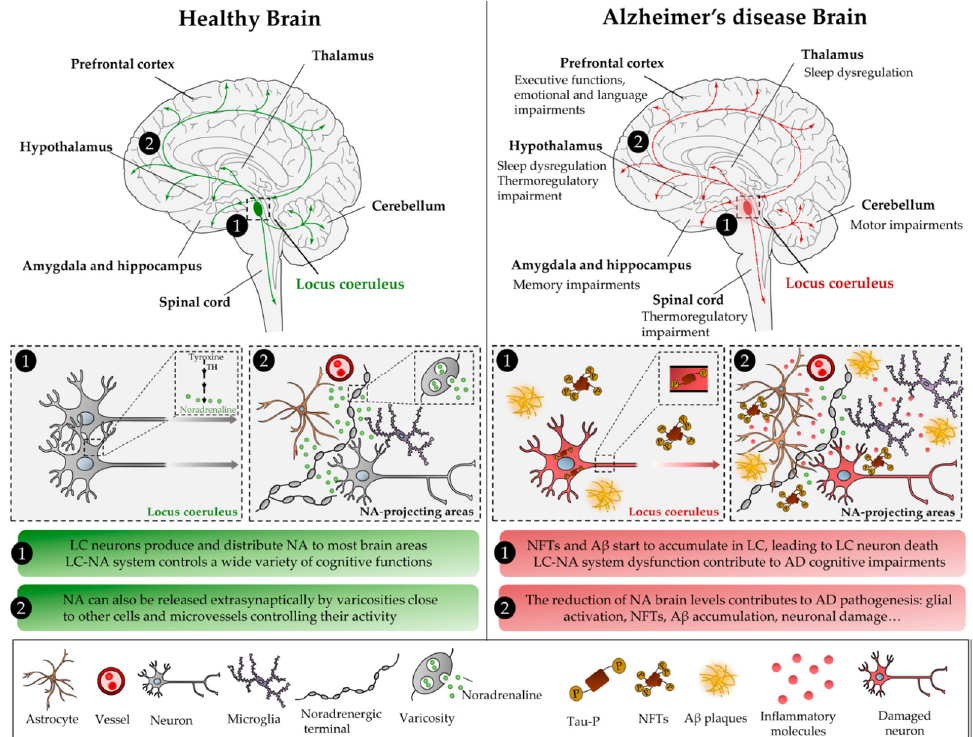
Figure 1. Main alterations in the CNS resulting from locus coeruleus degradation in Alzheimer´s